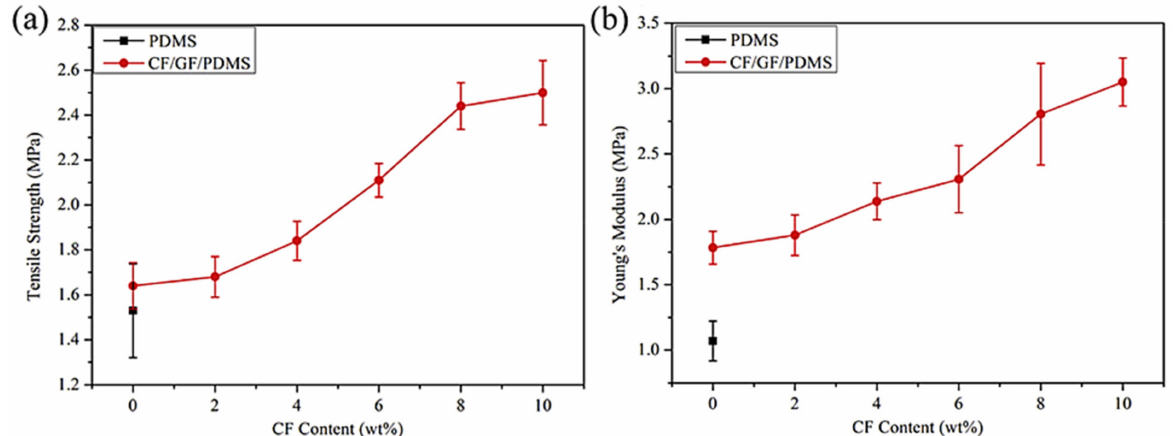
Figure 10. ( a ) Typical tensile strength and ( b ) Young’s modulus of nanocomposite materials PDMS = poly(dimethyl siloxane); CF/GF/PDMS = carbon fiber/graphene nanofoam/poly(dimethyl siloxane). Reprinted with permission from Ref. [88]. 2016, Elsevier.